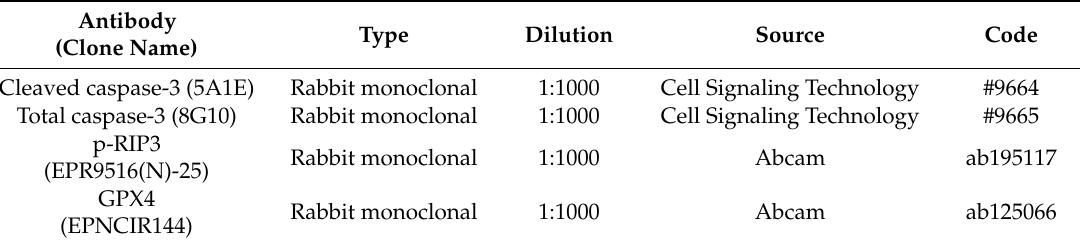
Table 3. The list of antibodies used for Western